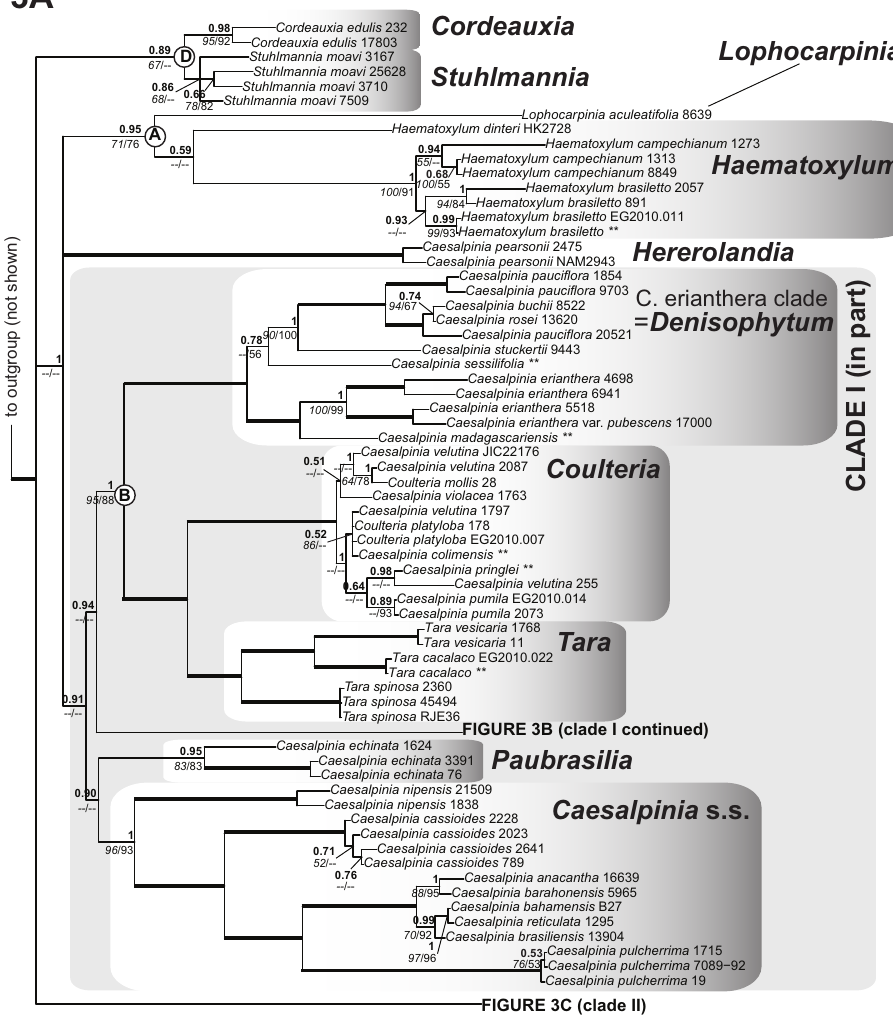
FIGURE 3C (clade II)